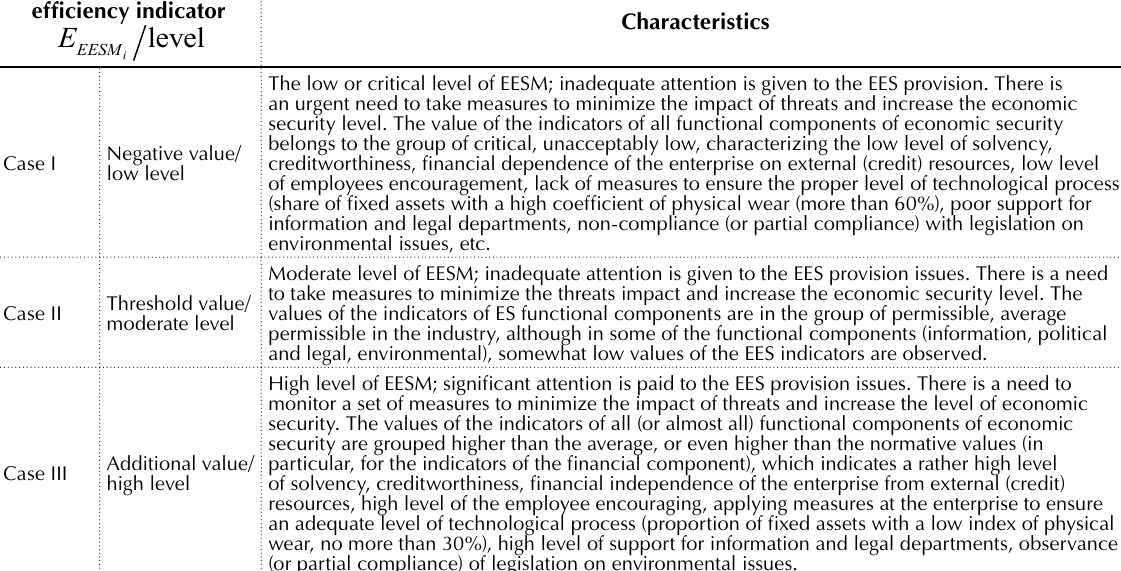
Source: Nikitina (2013).